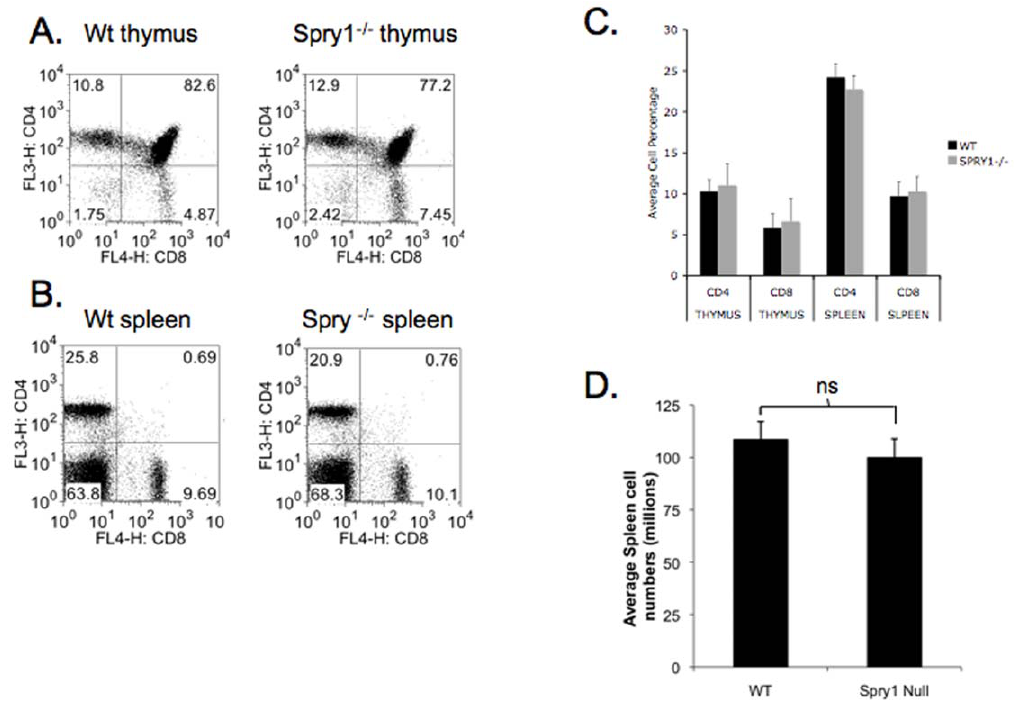
Figure 2. Loss of Spry1 in CD4 + and CD8 + T cells does not affect T cell development. B6 Lck Cre mice were crossed to Spry1 flox mice and thymuses ( A ) and spleens ( B ) were analyzed for CD4 and CD8 percentages by flow cytometry. C. Grapical representation of thymus and spleen CD4 + and CD8 + T cell percentages from wild type and Spry1 Flox/Flox Lck cre mice. D. Graphical representation of splenic cell numbers of wild type and Spry1 Flox/Flox Lck cre mice. Error bars represent one standard deviation of the mean. All experiments were performed at least three times. Data are representative of 5 mice per group.